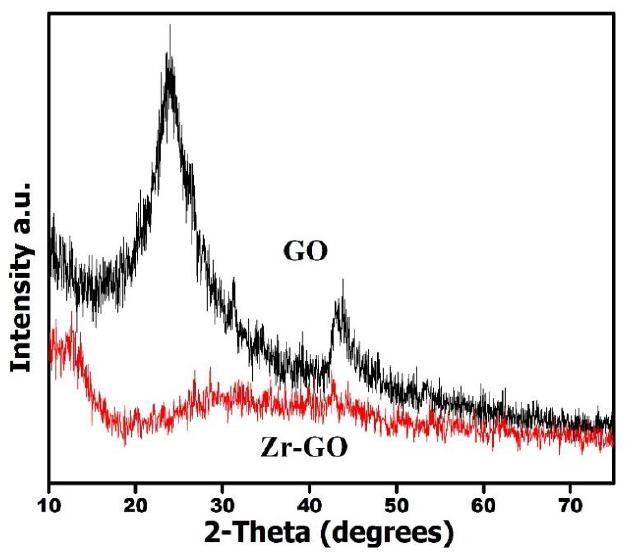
Figure 5. XRD pattern of GO and Zr-GO. Table 1. Summary of surface area, pore volume and average pore diameter of GO and